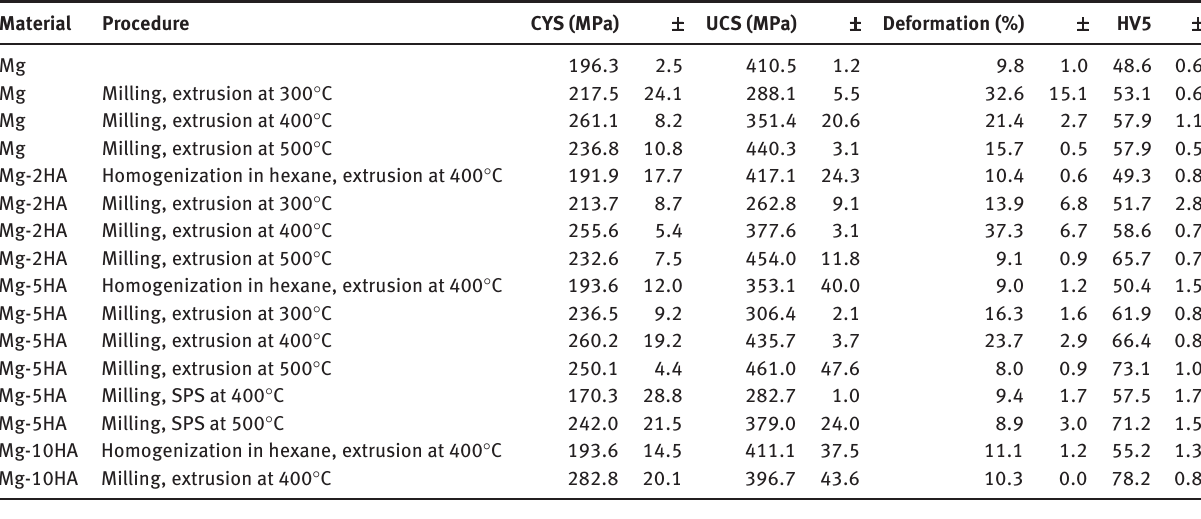
Table 2: Compressive mechanical properties of prepared composite materials.